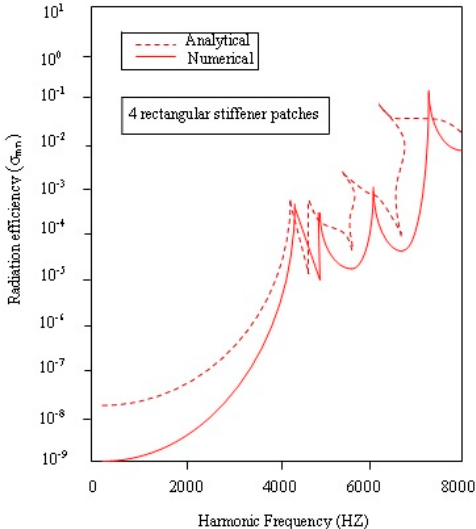
Figure 22. Comparison of radiation efficiency ( σ mn ) analytically and numerically for annular plate attached with 4 rectangular stiffener patches and having parabolic decreasing thickness variations (Case I) for taper ratio T x = 0.75.